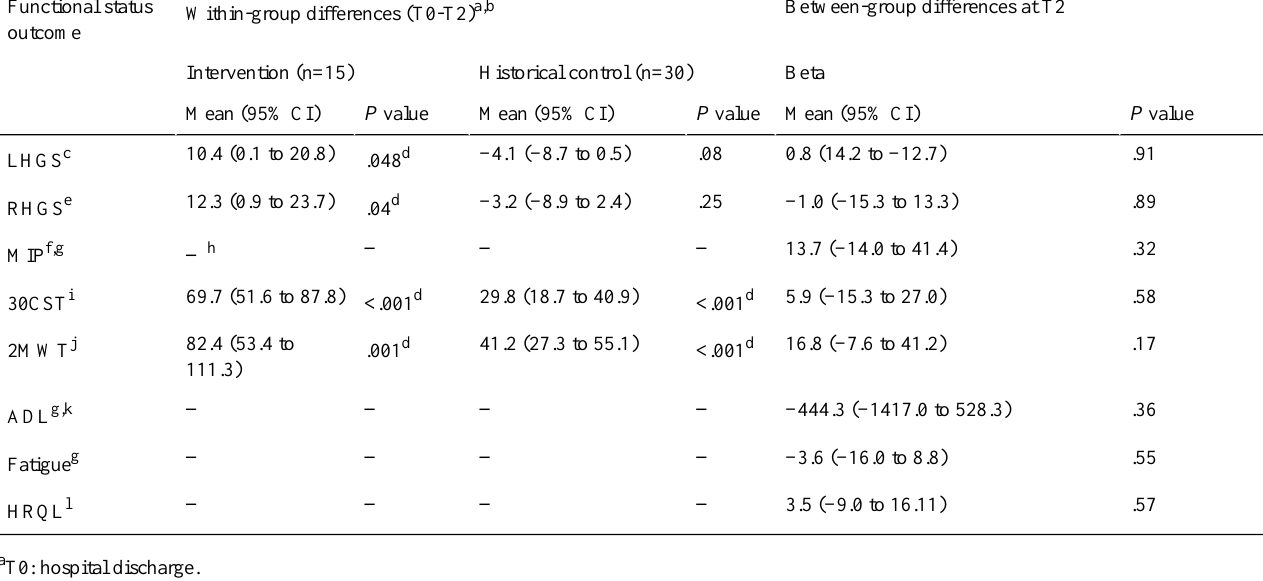
Table 4. Within-group differences between hospital discharge (T0) and 3 months post operation (T2) and between-group differences at T2 in measures of functional status. Within-group differences represent the differences in functional status between T0 and T2. Beta values represent the differences in functional status between the historical control group and the intervention group at T2.